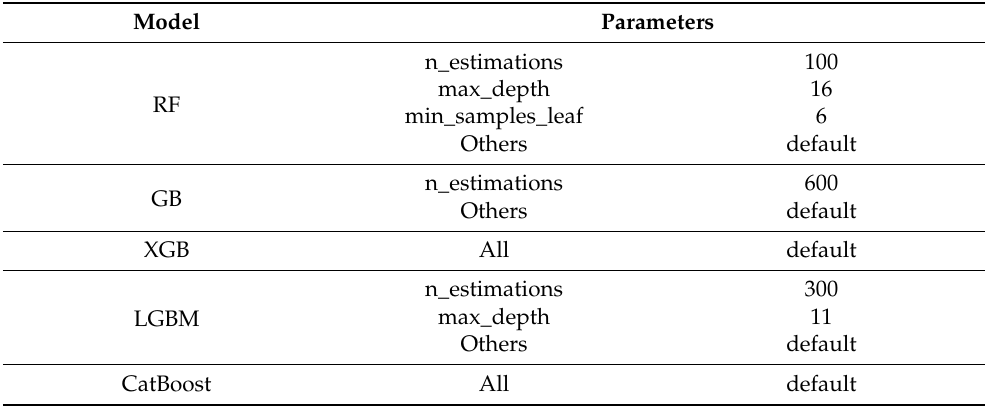
Table 6. Parameters of the retained